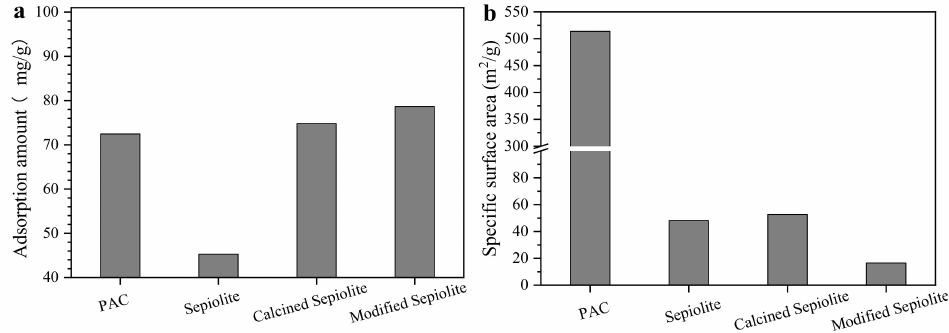
Figure 1. Comparison of Acid Orange II (AO) adsorption amount ( a ) and specific surface area ( b ) of di ff erent